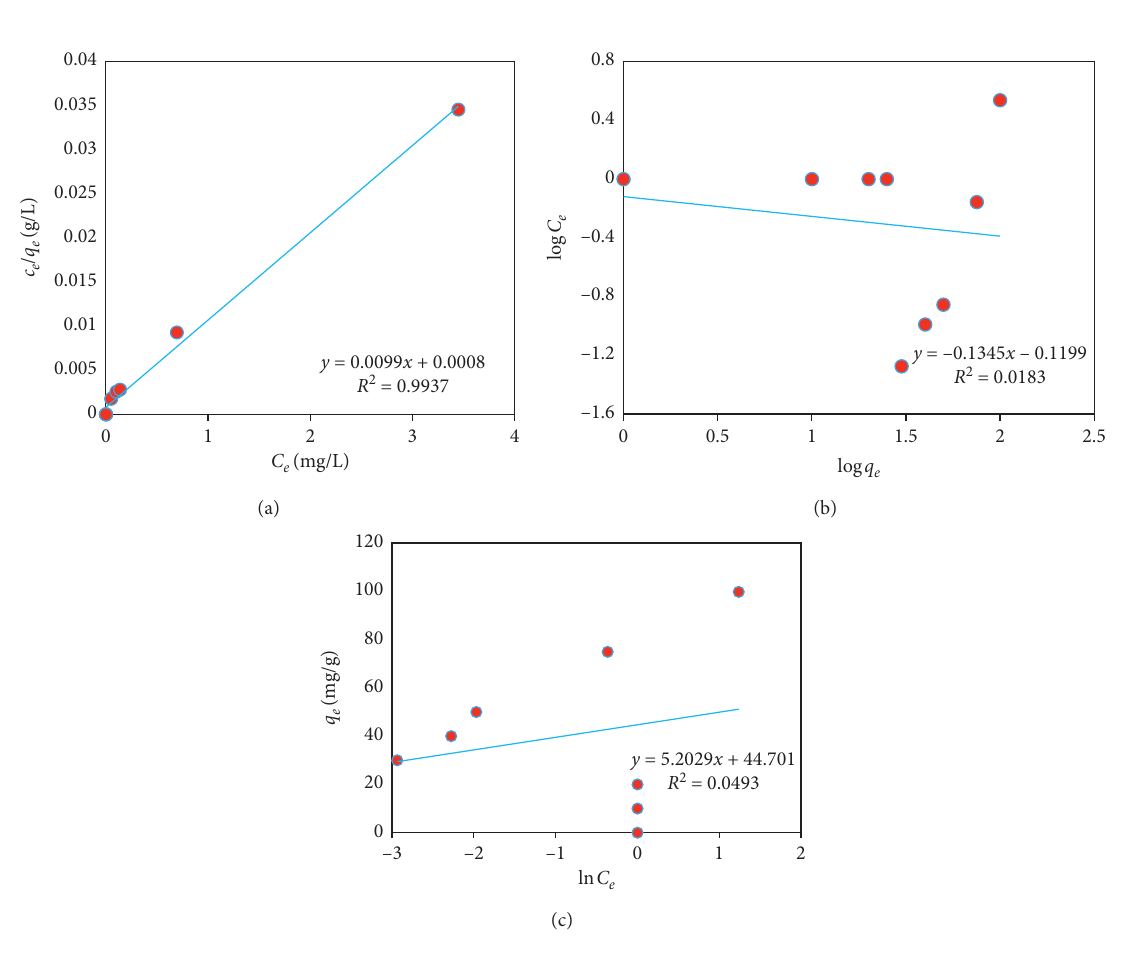
Figure 12: Linearized form of (a) Langmuir model, (b) Freundlich model, and (c) Tempkin model of lead ion. Table 4: Langmuir, Freundlich, and Temkin isotherm constants for Pb (II) uptaken by S-CNs. Langmuir equation Freundlich equation Temkin Metal